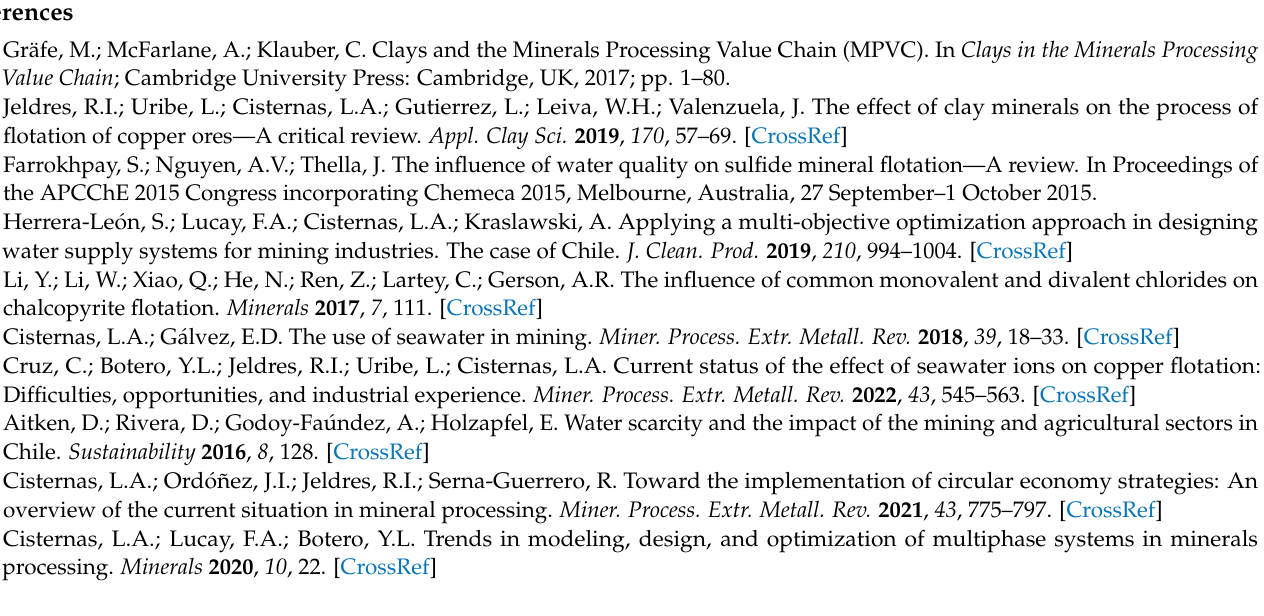
Table S2: RBFNN neuron data for